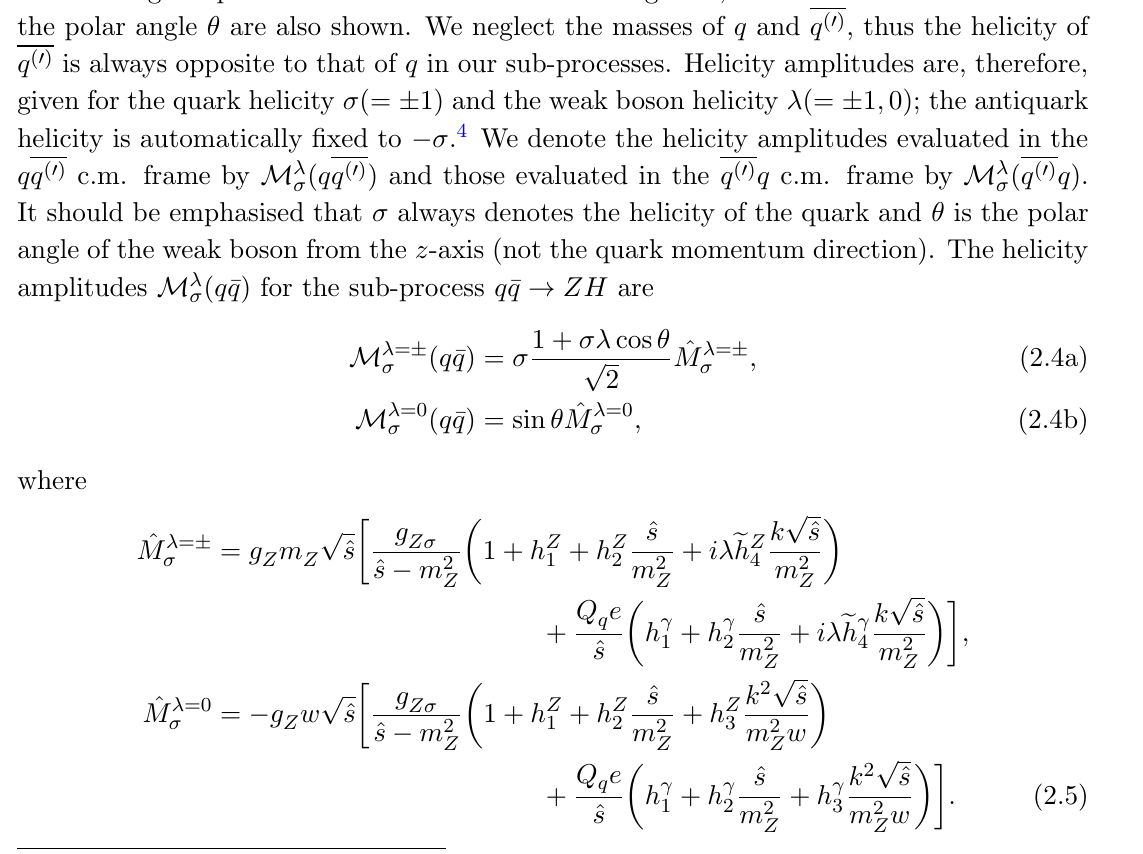
1), the antiquark (cid:6)